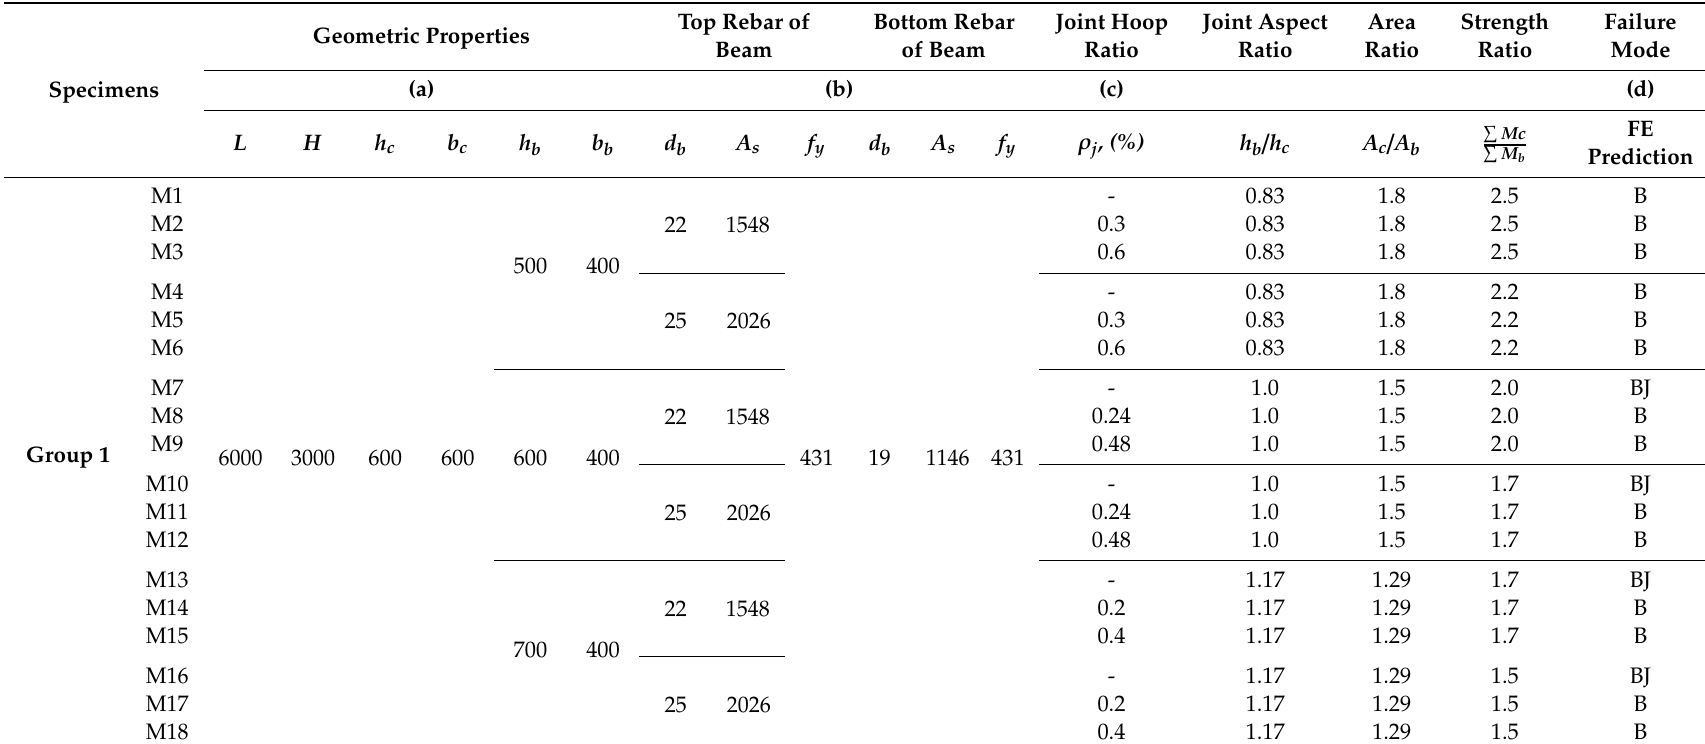
Table A2. Specimen Properties and Analysis